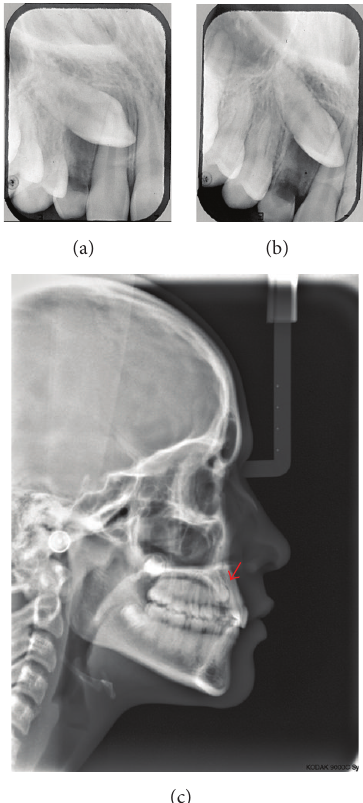
Figure 3: Initial documentation: exams imaging for diagnosis of impacted canine. (a) and (b) are periapical radiographs with Clark technique (note that in (b) the tooth moved distally, indicating its position by palatal); red arrow indicates the impacted tooth (c).